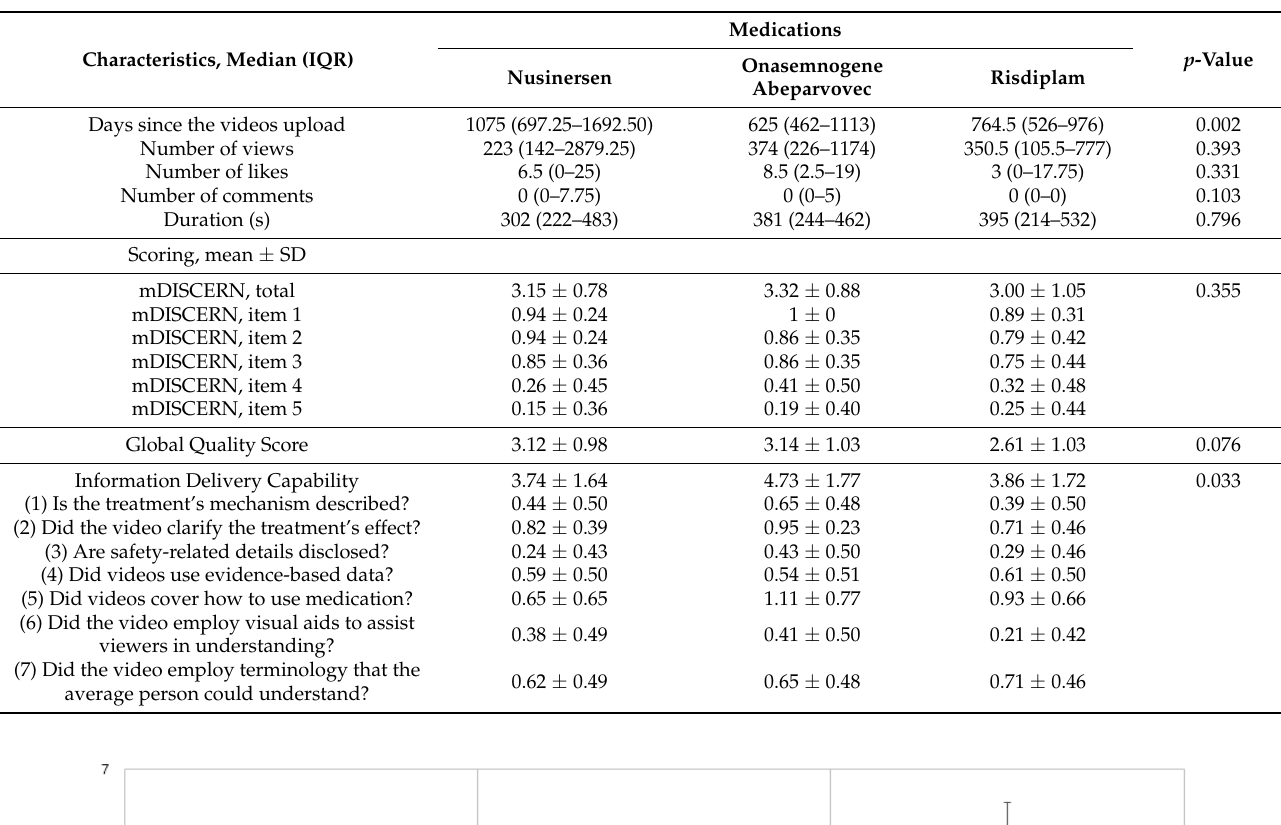
Table 2. Characteristics of the videos according to SMA treatment.